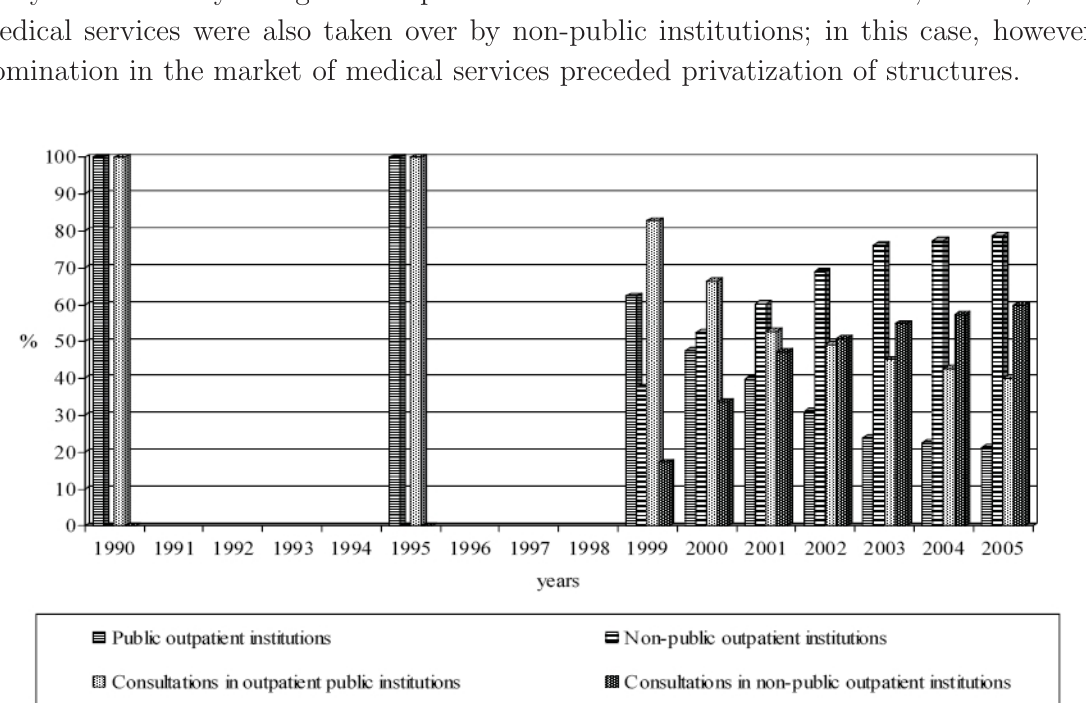
Fig. 1 Effects of the ownership transformation of outpatient institutions in urban